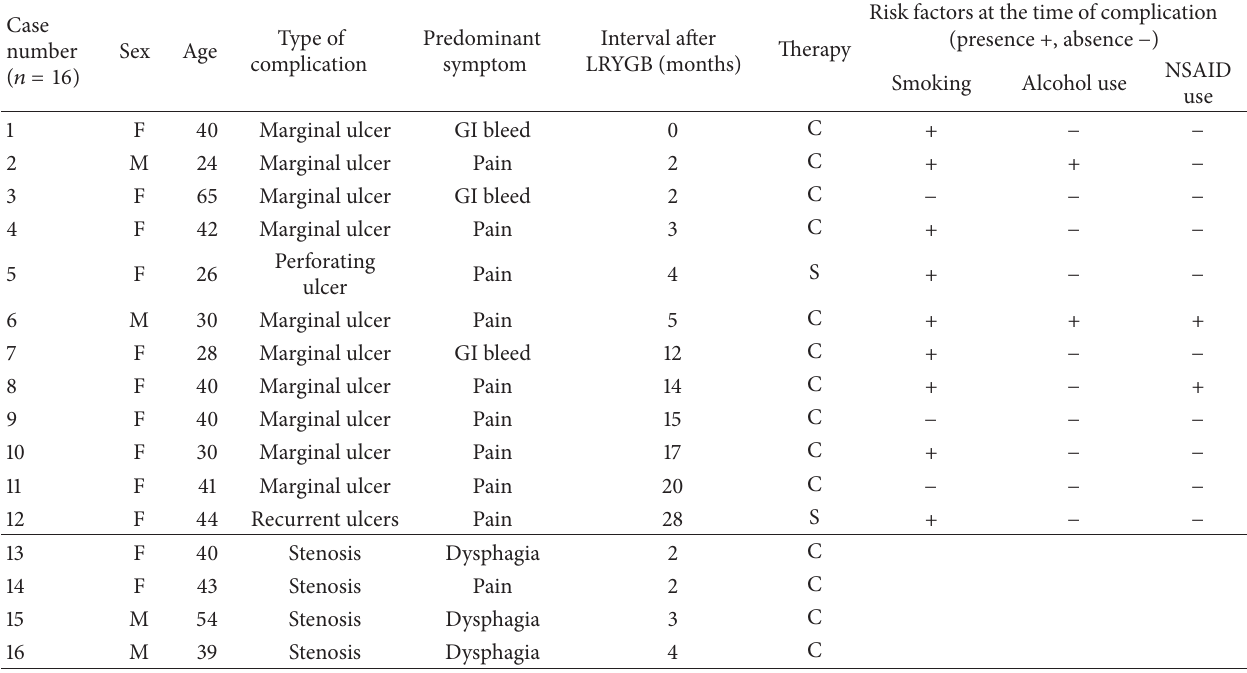
Table 2: Patient data at the time of complication.